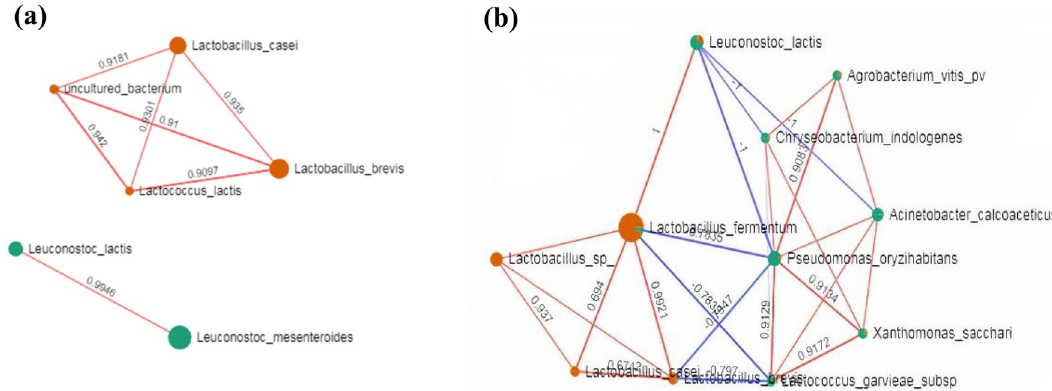
Figure 7. Taxa–taxa interaction at species level using SPARCC set at permutation value of 200, p- value < 0.05, correlation > 0.6: (a) sweet corn and (b) Napier. Blue edges represent negative correlation, whereas orange edges represent positive correlation. The proportion of bacterial taxa is shown in green for fresh crops and orange for